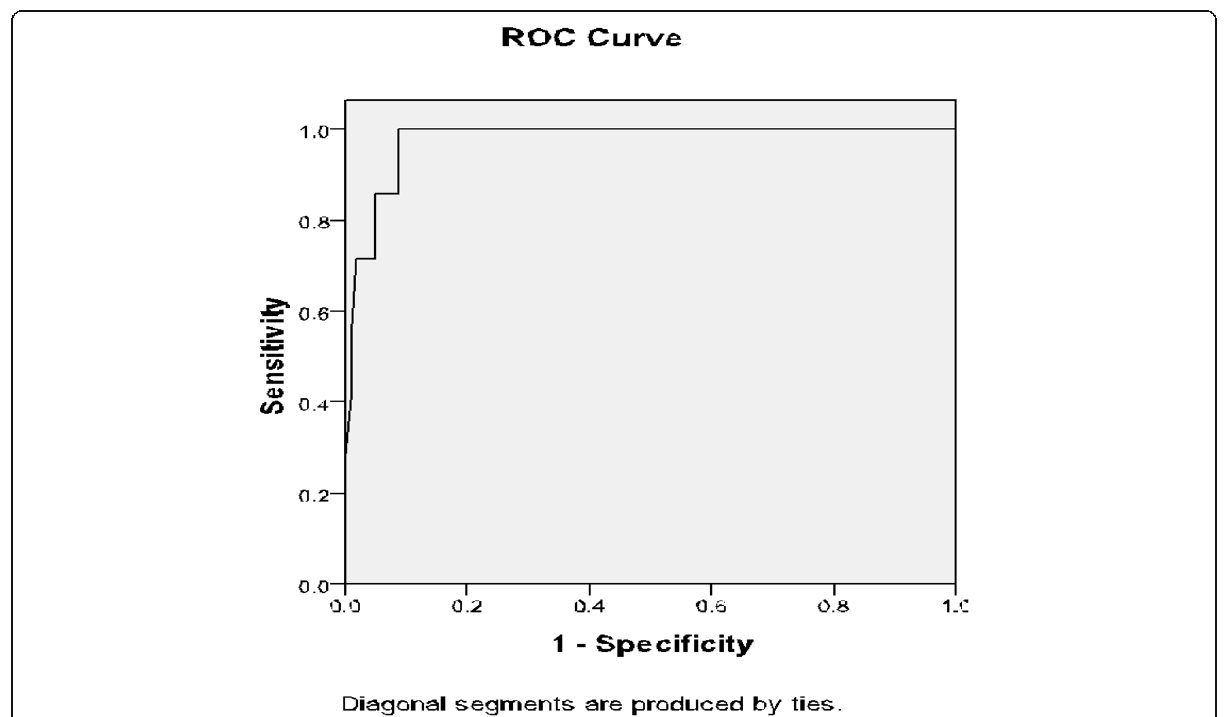
Fig. 1 ROC curve for B/A ratio. The ROC curve shows that a B/A ratio of 9.6 was 100% sensitive and 91.4% specific and 92% accurate to detect poor neurologic outcome in neonates suffering from severe neonatal hyperbilirubinemia at 3 months of age